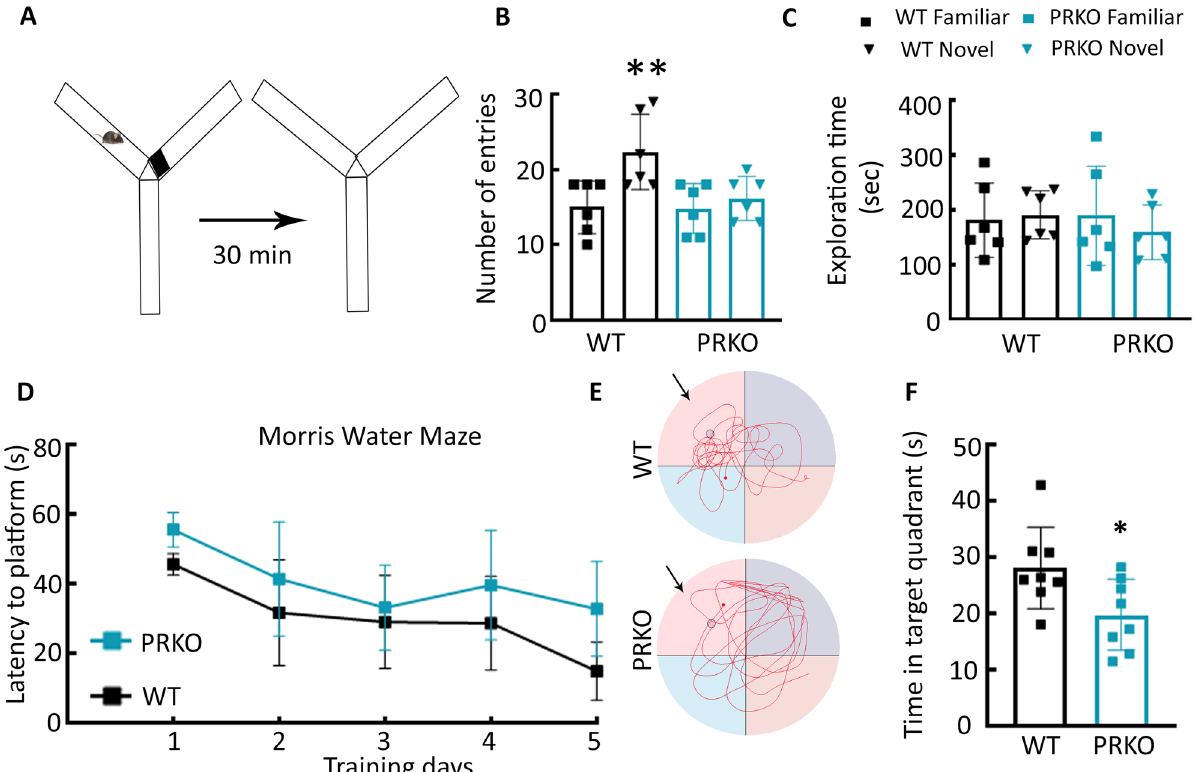
Figure 6. Effect of PR deletion on Y maze forced alternation and Morris Water Maze tasks. ( A ) A schematic of the Y maze forced-alternation test. ( B ) The number of entries in the novel arm by PRKO and WT males in a Y maze forced-alternation task, n = 6 each, * p = 0.0074, ANOVA with Sidák’s multiple comparison WT familiar vs WT novel. ( C ) The time spent exploring the novel and familiar arms. ( D ) Latency to reach the platform during training, n = 8 each. ( E ) Track plots from representative WT and PRKO mice during the probe trial on day 6. The arrow marks the quadrant that held the escape platform during training sessions. Please note that the WT animal kept swimming in the region around the location of the platform (marked by the circle) during the probe trial whereas, the PRKO mouse swam in all the quadrants. ( F ) The time spent in the target quadrant during the probe trial, * p = 0.0277, student’s